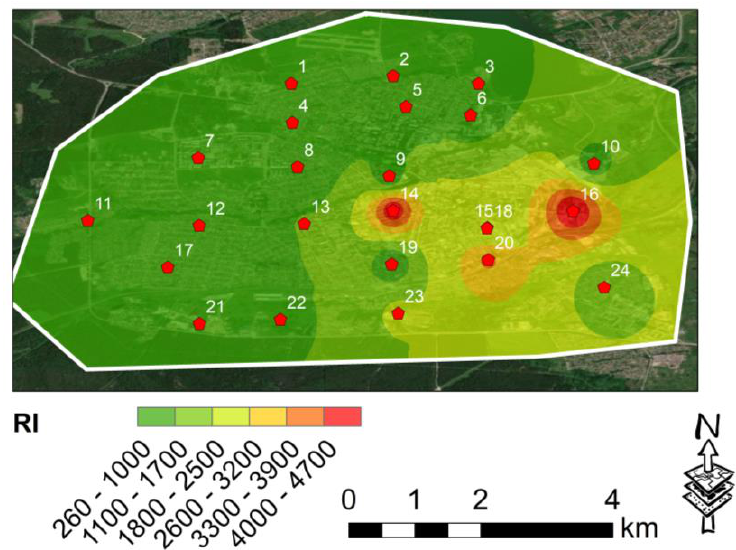
Figure 8. The distribution of risk index illustrating locations with significant values.